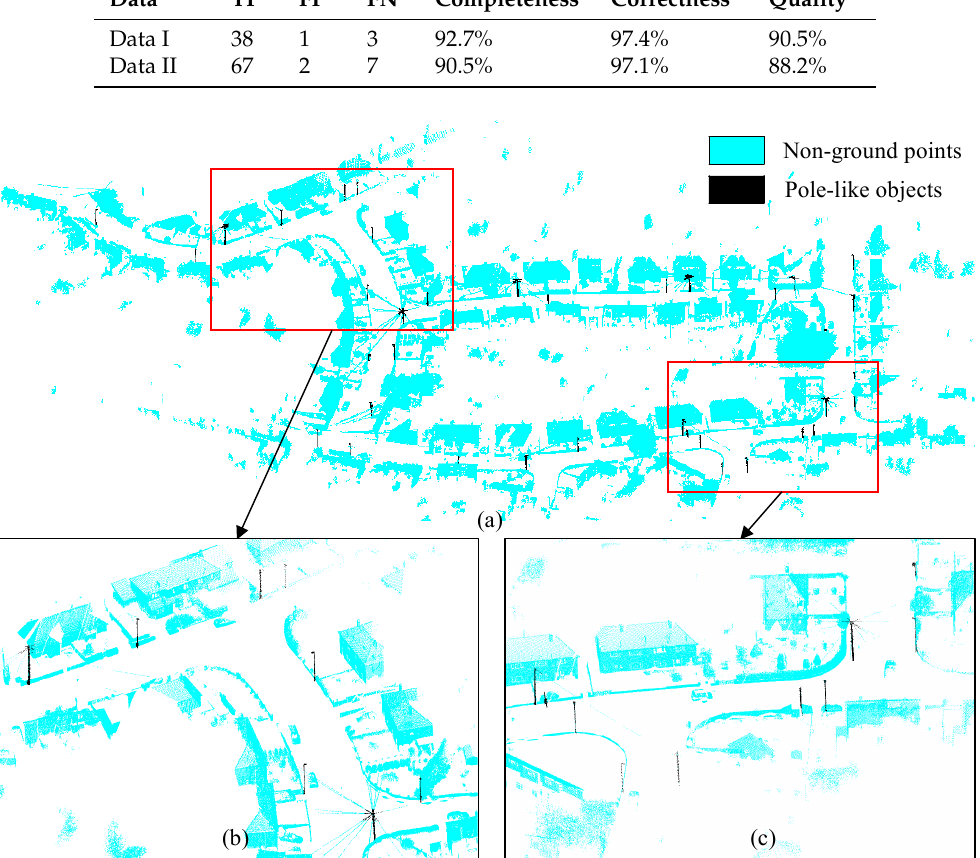
Figure 9. Results of PLOs extraction in Data I. ( a ) Non-ground points colored in cyan and PLOs colored in black; ( b ) view 1; ( c ) view